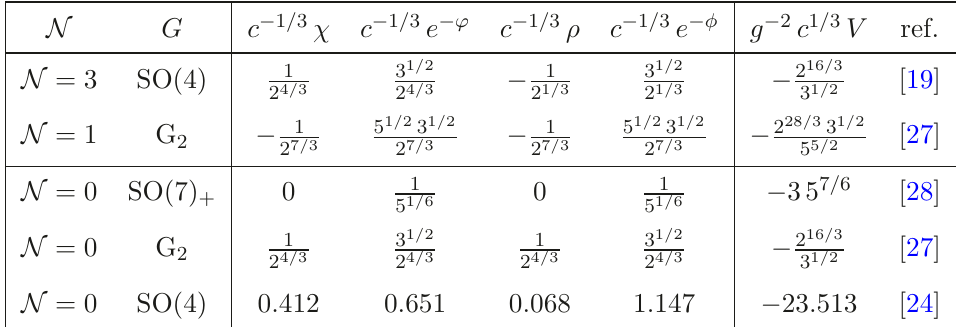
Table 1 . Critical points of the scalar potential (2.7), namely, of = 8 ISO(7)-dyonically-gauged N supergravity with invariance equal or larger than the SO(4) subgroup of SO(7) defined in (2.1). For each point we give the residual supersymmetry and bosonic symmetry G within the full = 8 N N theory, its location, the cosmological constant V and the reference where it was first found. We have employed the shorthand c m/g . All of these data are reproduced from ≡